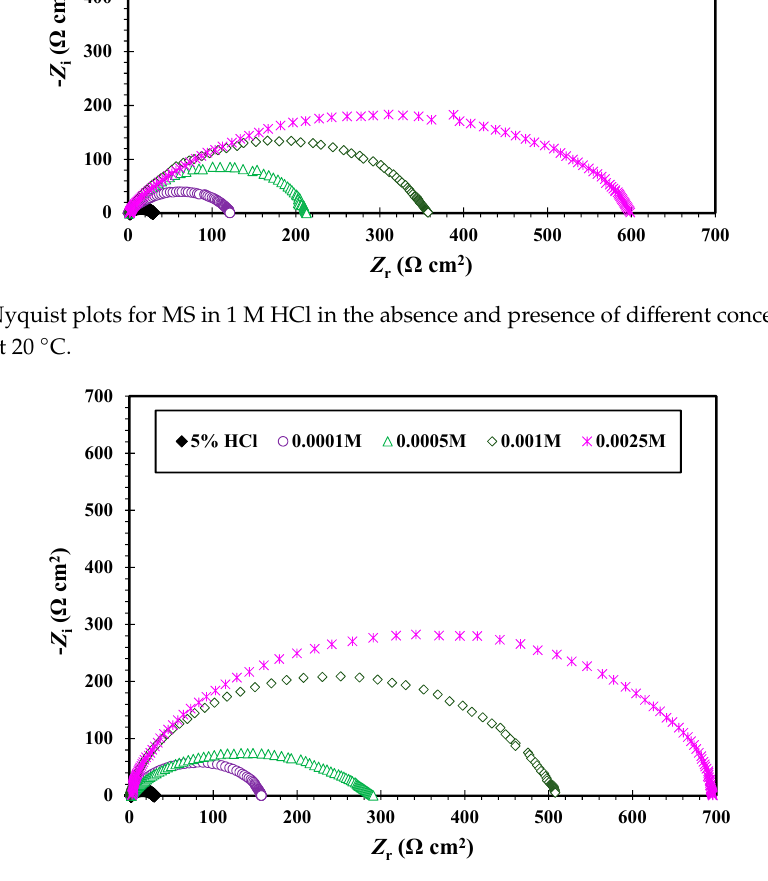
Figure 9. Nyquist plots for MS in 1 M HCl in the absence and presence of different concentrations of CGSES16 at 20 °C.